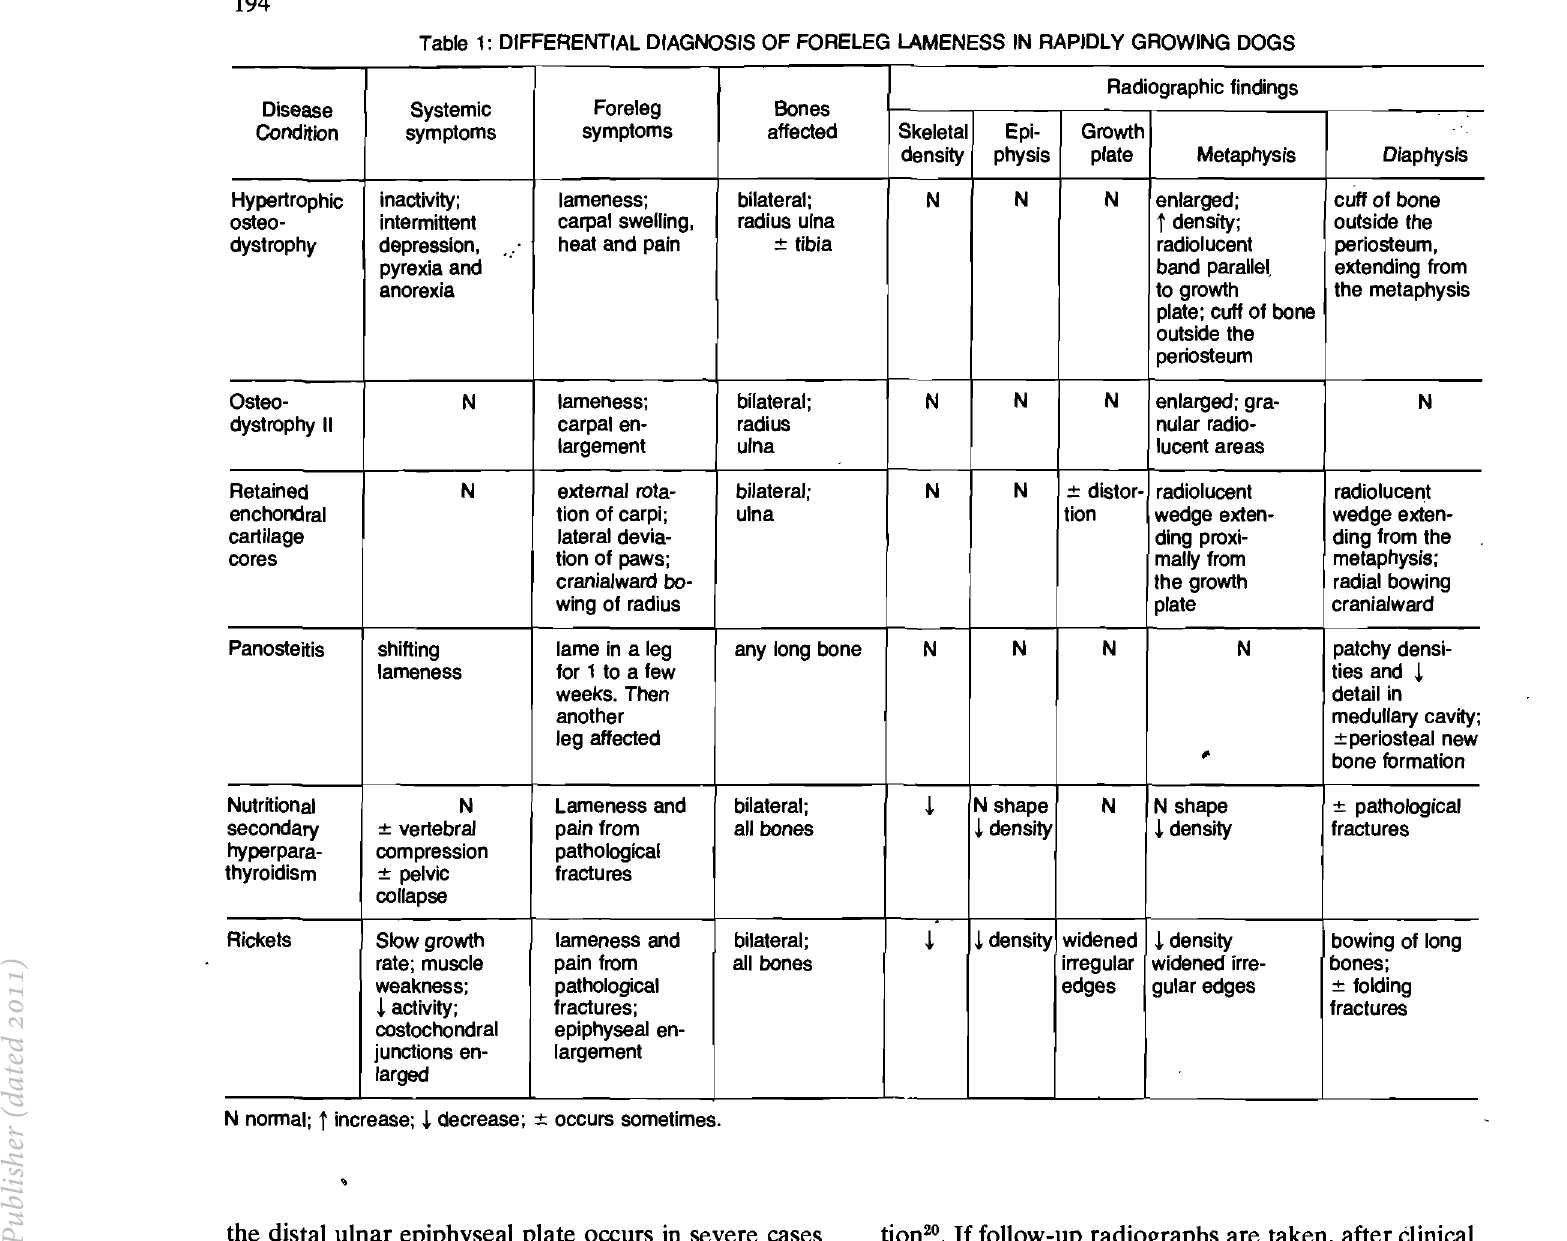
Table 1: DIFFERENTIAL DIAGNOSIS OF FORELEG LAMENESS IN RAPIDLY GROWING DOGS